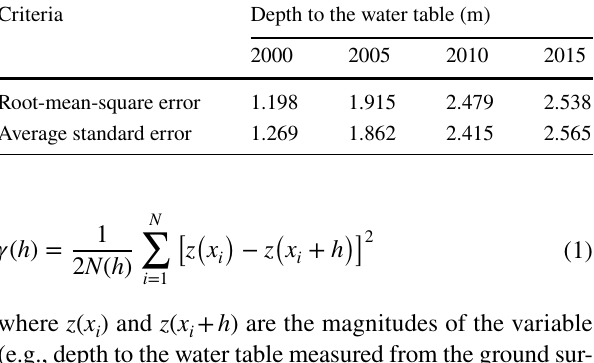
Fig. 4 Results of the semivariogram modeling for depth to the water table data for 2000 Table 2 Cross-validation for the predictive models